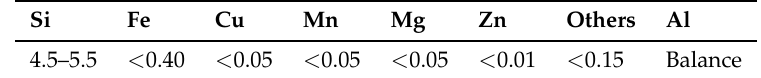
Table 1. Typical element composition of AA4043 Ø1.2 mm wire in wt.% [14].